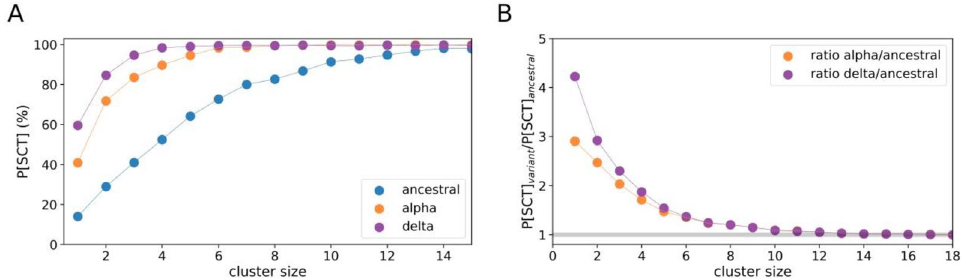
Figure 3. Probabilities of sustained community transmission (SCT) for different variants. ( A ) Summary of probabilities of SCT for the ancestral variant (blue), alpha variant (orange) and delta variant (violet). ( B ) Relative risk of SCT for alpha versus ancestral (orange), and for delta versus ancestral (violet) estimated as the SCT probability for a highly-transmissible variant divided by the SCT probability for ancestral. The grey line denotes when the SCT probability for both variants is the same. Simulations used a level of testing ∼ 8 k daily tests and a moderate Q&I leakage ( ∼